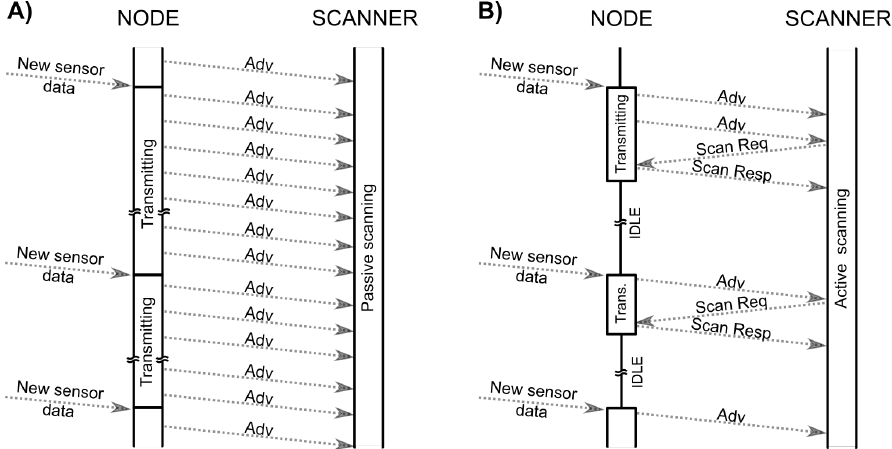
Figure 1. BLE connectionless communication using ( A ) passive and ( B ) the proposed communication scheme. In the proposed scheme the reception of SCAN_REQ allows the node to terminate ADV transmission in order to preserve energy and improve spectrum sharing.